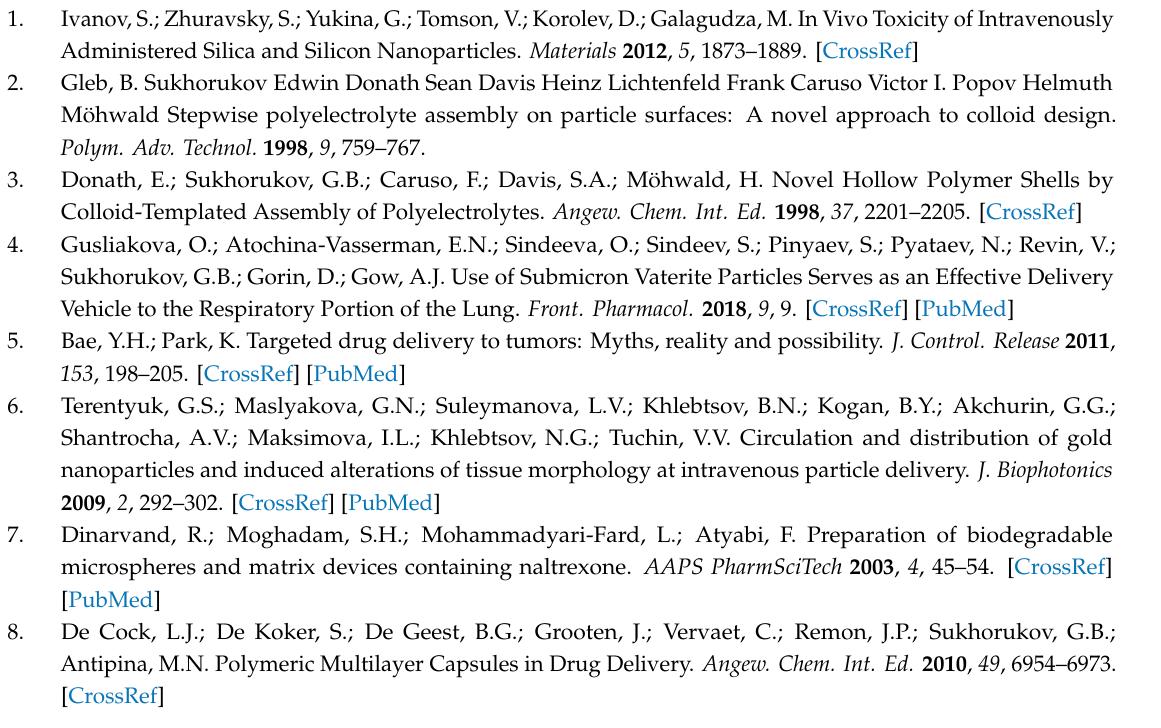
Figure S1. DLS of magnetite particles, Figure S2. SEM images of BSA / TA capsules (without MNPs), Figure S3. The e ff ect of various biological fluids on the carrier stability, Figure S4. The e ff ect of various biological fluids on the MNPs (BSA / TA) carrier stability after centrifugation, Figure S5. The percent of viable cells (a- Hela, b- fibroblasts) after incubation (free cells set as 100%), with added BSA-TA and MNPs(BSA-TA) carriers measured by Alamar blue method. The carriers were added to cells at concentration from 10 to 50 capsules per cell, Figure S6. MR T2 images of mouse before and 1 h, 2, 4, 25 days after intravenous injection of a microcapsule suspension. The dotted orange line shows the area of the